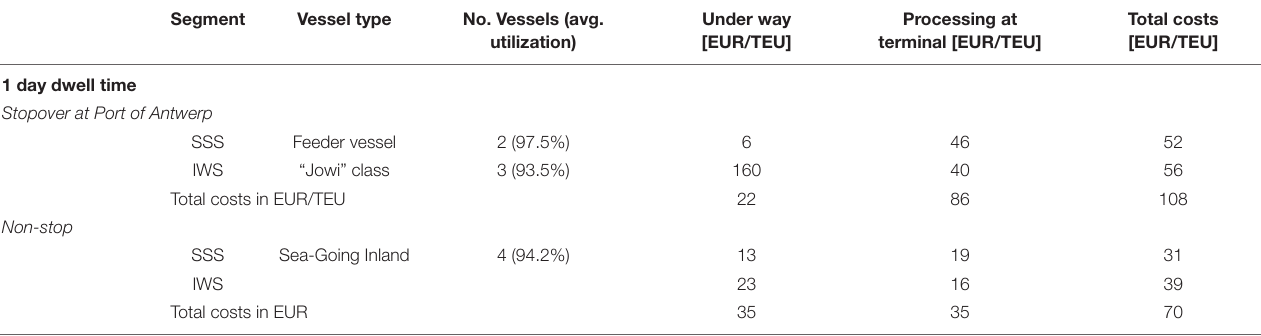
TABLE 10 | Breakdown of costs on the hinterland connection between transport and logistics hub and NRW per TEU for the solution with stop over at the Port of Antwerp and for the non-stop solution, adapted from (Assbrock et al.,